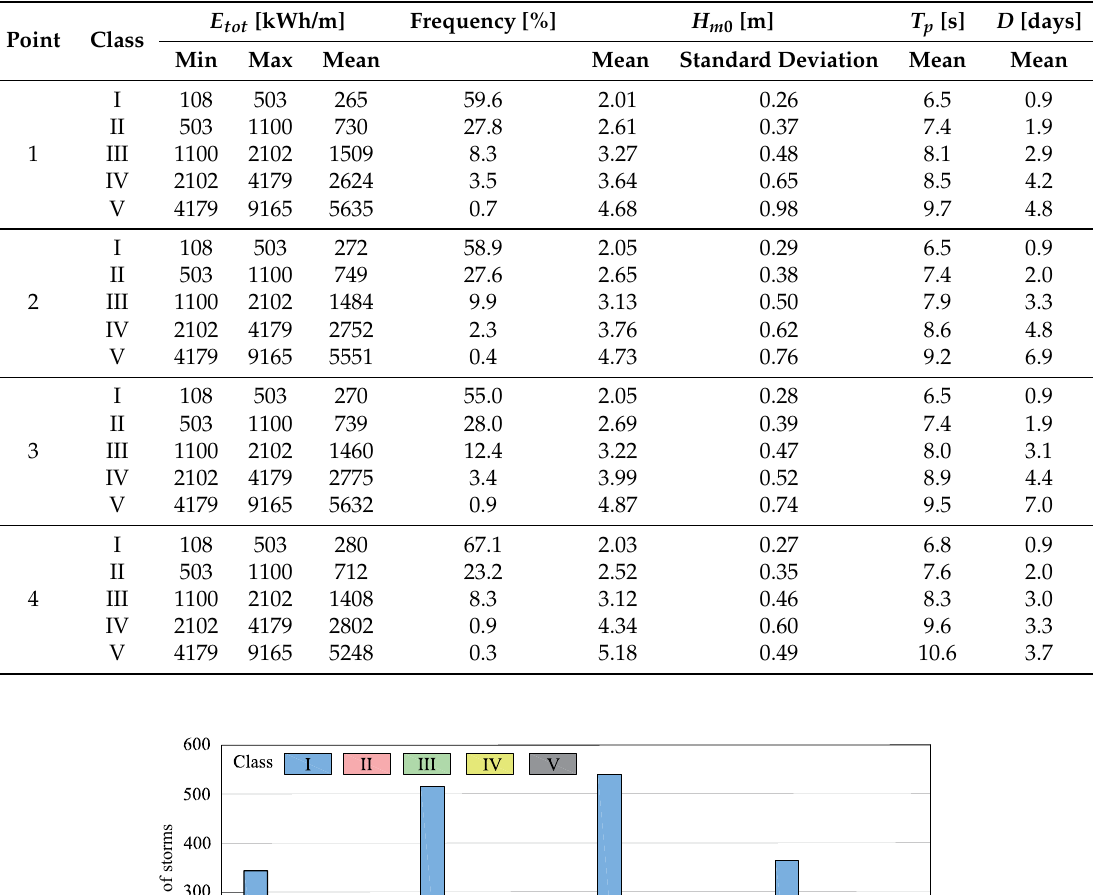
Table 1. Storm characteristics at each prediction point: class, energy ( E tot ), frequency of storms, significant wave height ( H m 0 ) peak period ( T p ), and duration ( D ).